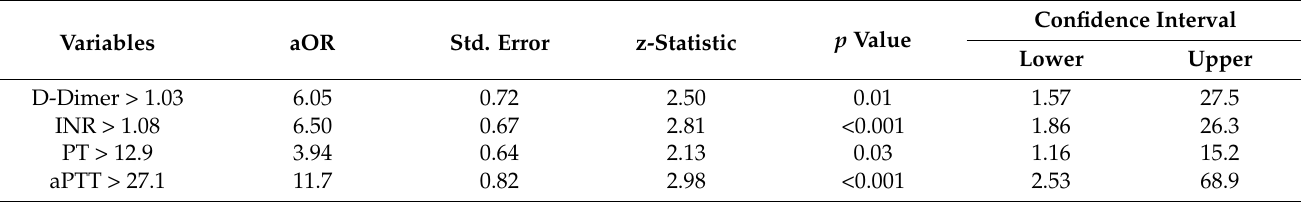
Table 4. Multivariate binominal logistic regression